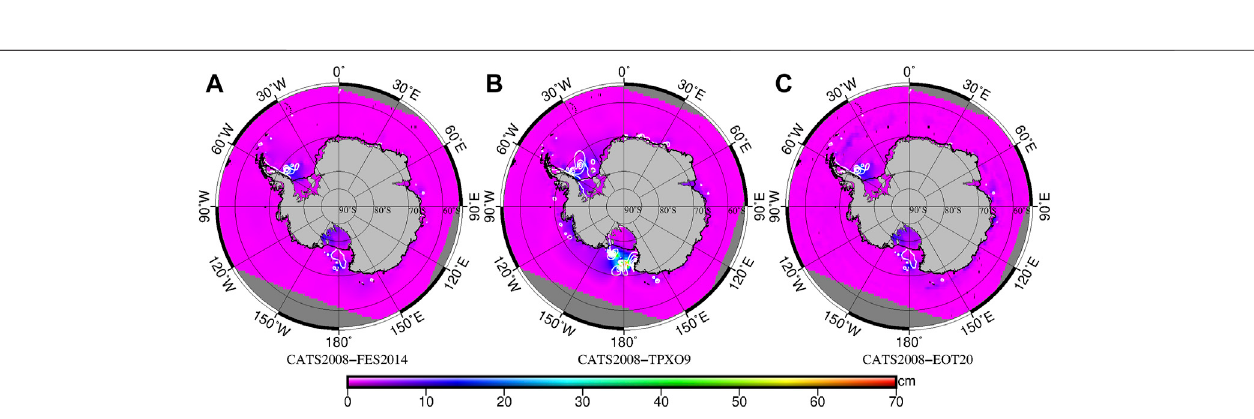
areas, and the amplitude changes rapidly.